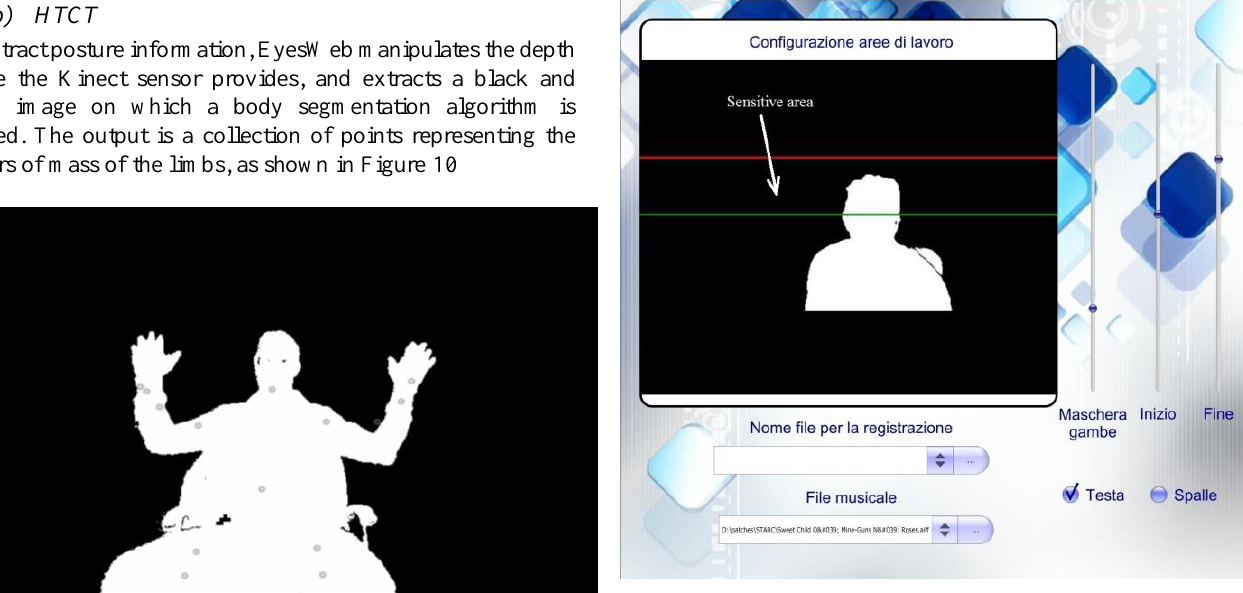
Figure 10. Points obtained from body segmentation algorithm From this information, EyesWeb evaluates whether the posture is correct and generates a log file containing frontal and lateral displacement (in mm) between head, shoulders, and waist and the occupation value frame by frame of a sensitive area therapists defined (see Figure 12).